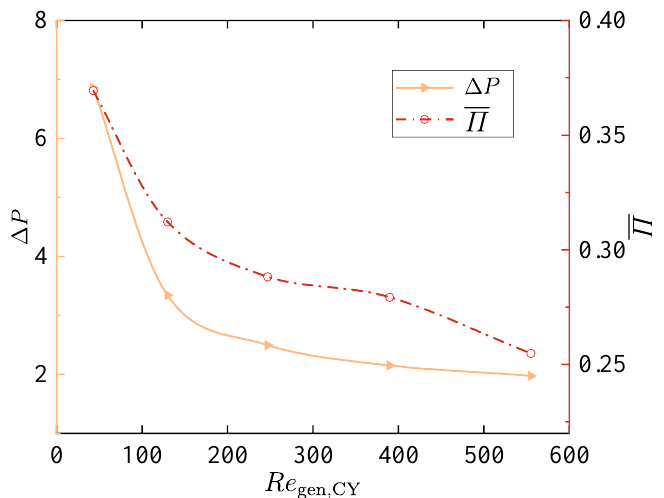
Figure 13. Profiles of the dimensionless ( a ) velocity, ( b ) temperature, ( c ) shear rate and ( d ) viscosity for different 𝑅𝑒 . The wavelength of the sinusoidal corrugation is 2𝐻 , and the wave amplitude gen,CY is 1/5𝐻 .